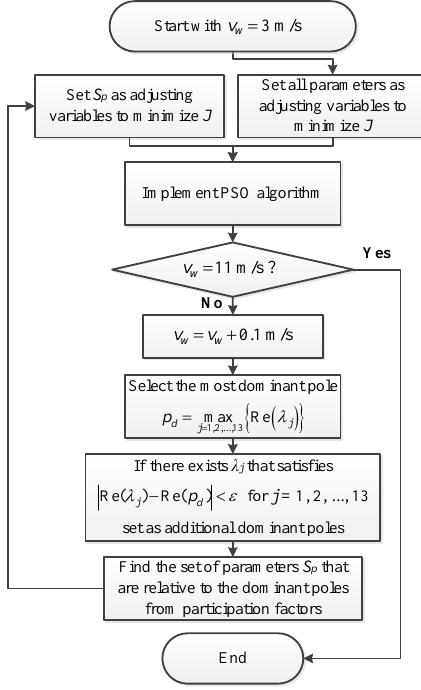
Figure 7. The whole flow chart of the proposed